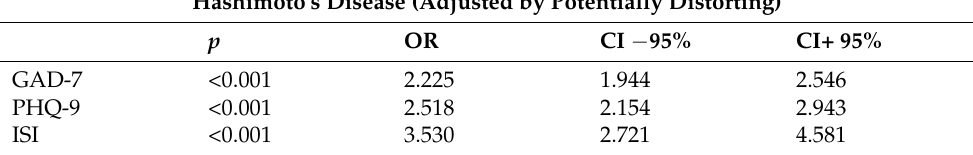
Table 4. Severity of mental health and insomnia in patients with Hashimoto’s disease (multivariable logistic